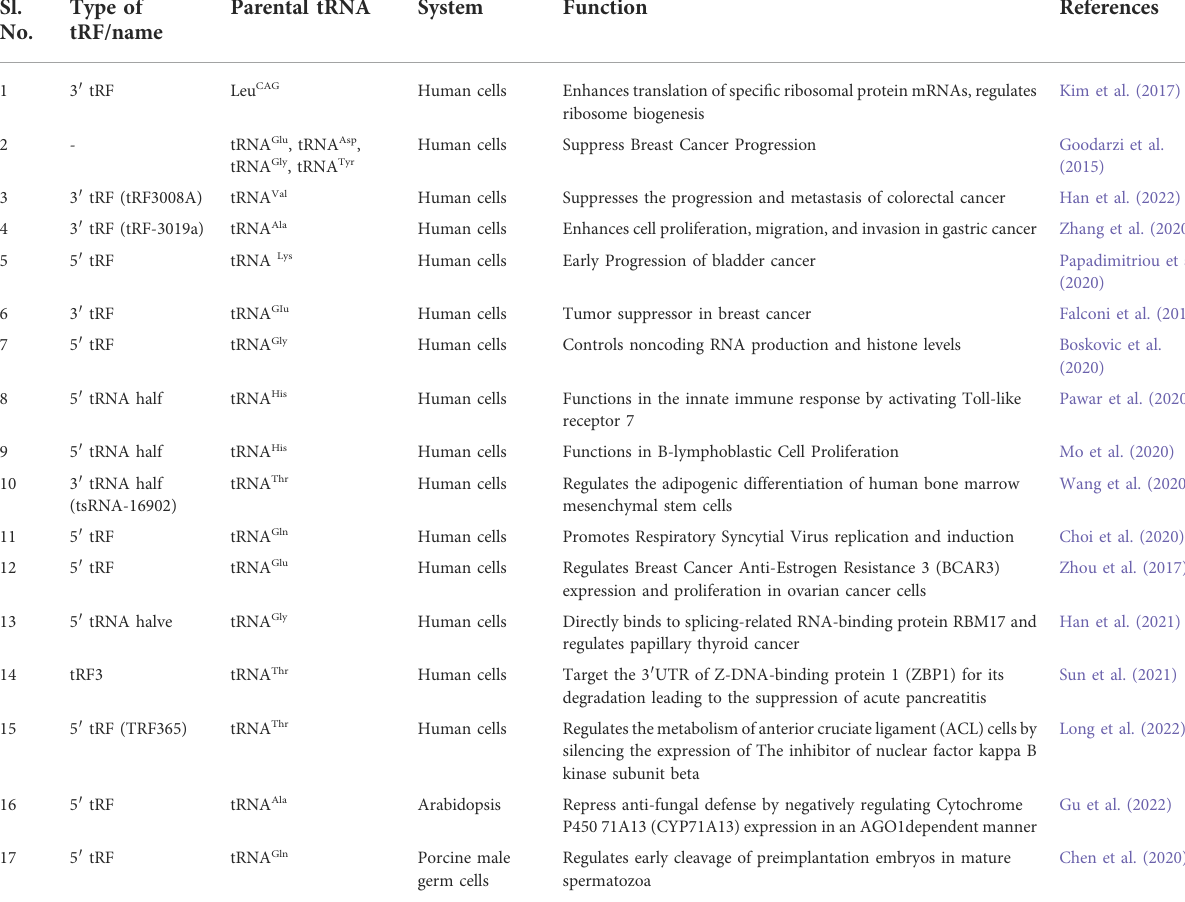
TABLE 2 Documented roles of speci fi c